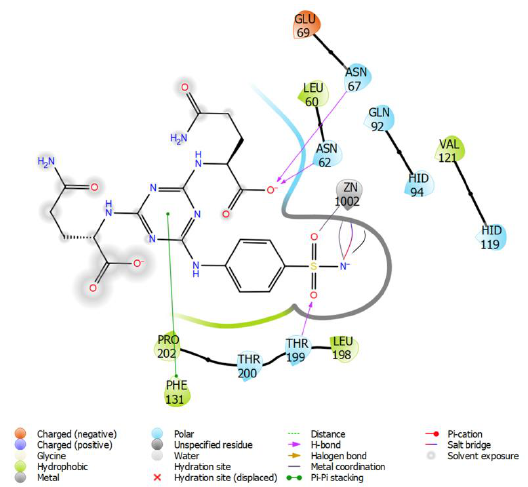
Figure 3. Intermolecular interactions of compound 7 (with Gln) docked into hCA II.